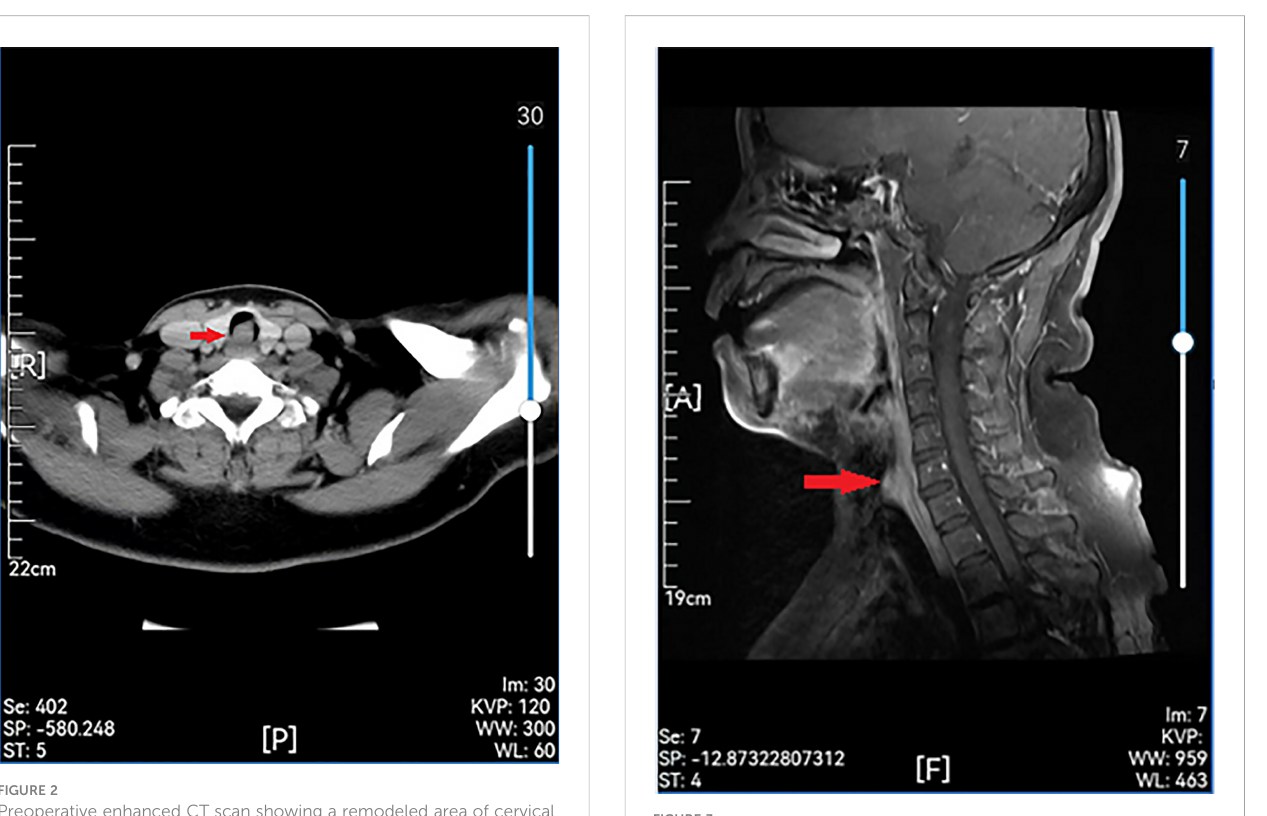
FIGURE 3 Preoperative enhanced MR showing a remodeled area of cervical with posterior wall erosion (red arrow).